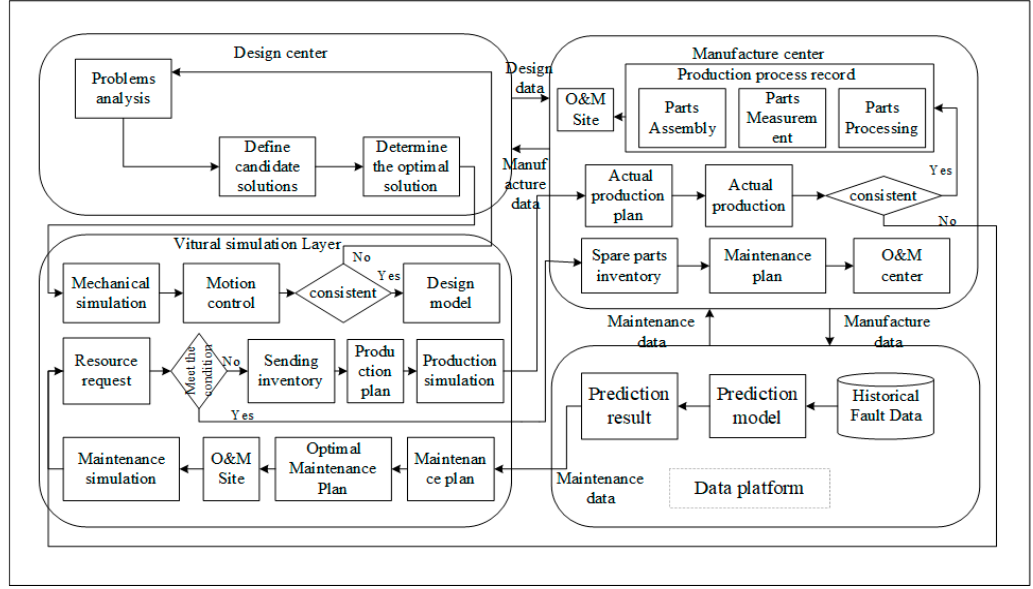
Figure 10. Digital ‐ twin ‐ driven EMU bogie fault handling operation mechanism. Figure 10. Digital-twin-driven EMU bogie fault handling operation